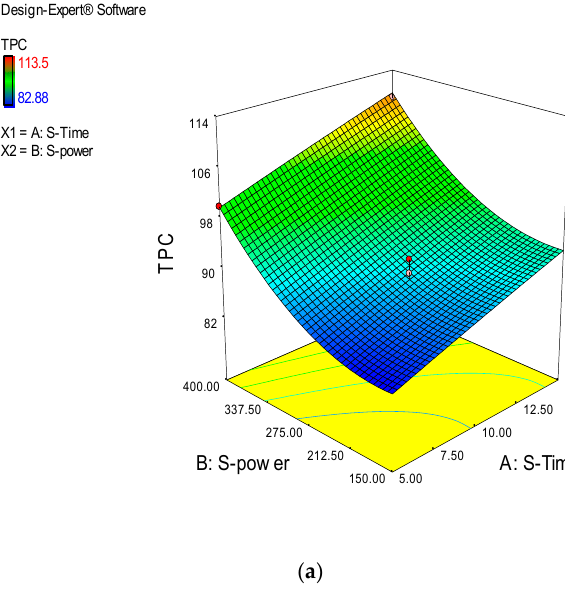
Figure 2. ( a ) Effect of ultrasound parameters (sonication time (factor A) and sonication power (factor B)) on the TPC–response surface and contour plots; ( b ) perturbation plot showing the relative significance of factors on the TPC values. Table 1. The experimental design used and values of the response. Run